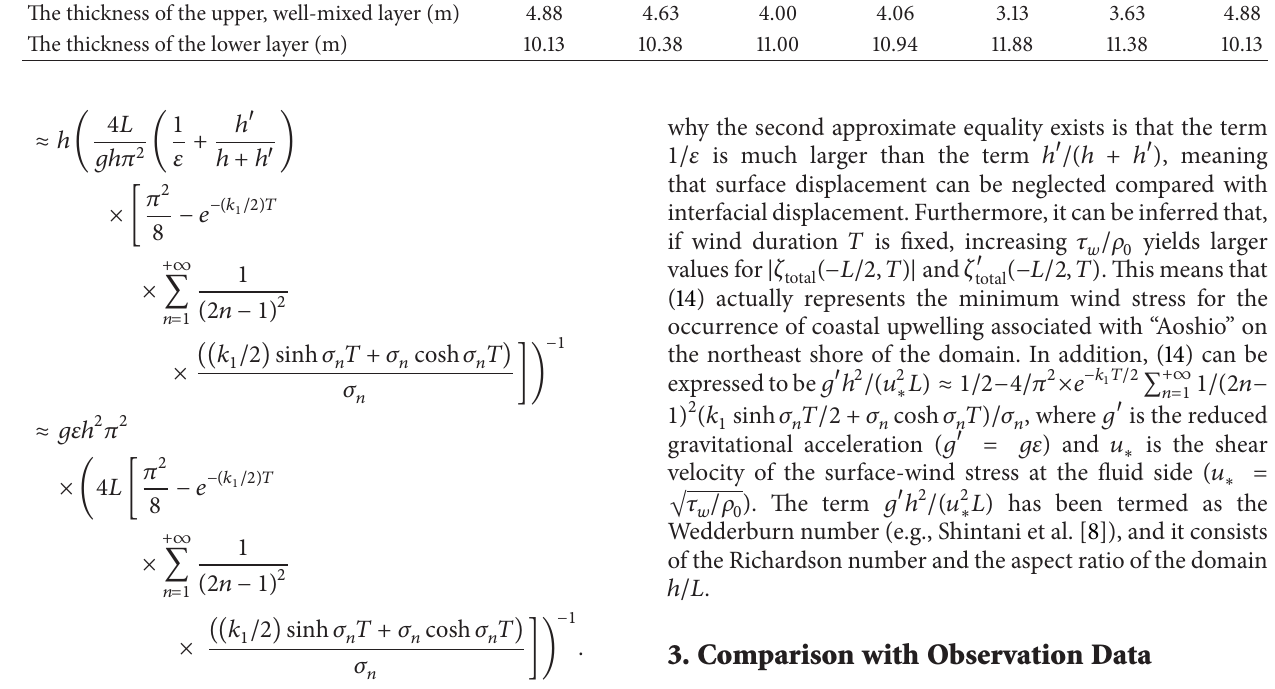
Figure 2: Presentation of the analytical model using typical parameter values in in Table 1. Table 2: Algebraically averaged thickness value of the upper well-mixed layer for each month, calculated based on real-time data taken from 2003 to 2010. May Jun. Jul. Aug. Sep. Oct.